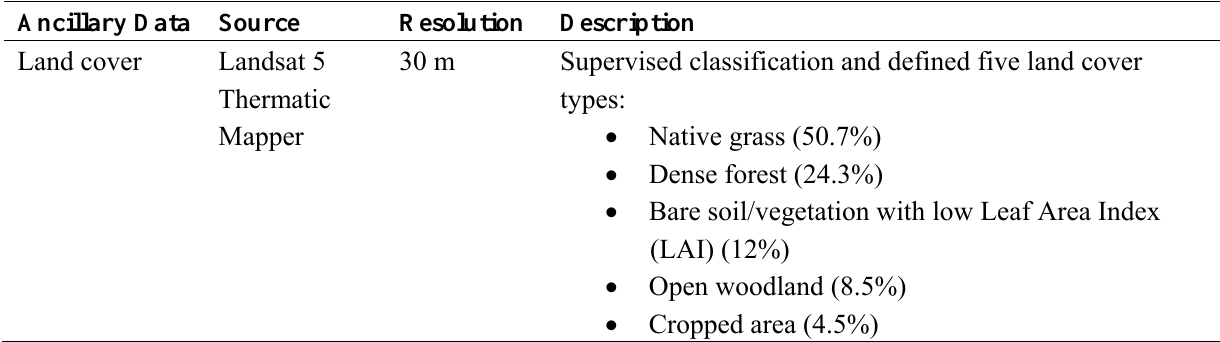
Table 1 . Summary of the ancillary data used for the L-MEB model